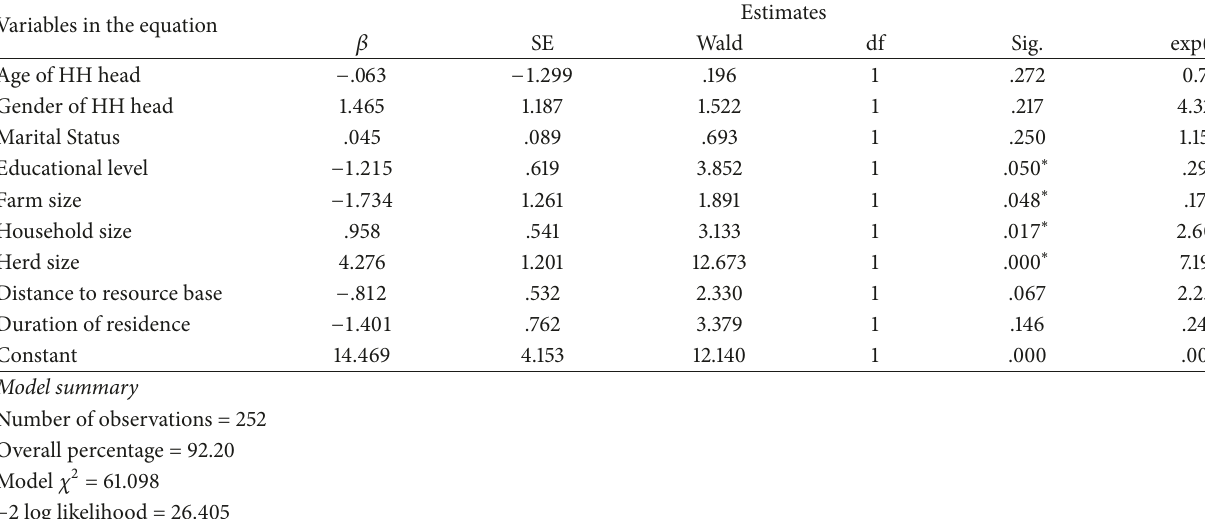
Table 6: Results of logistic regression indicating factor estimates that determine resources-use